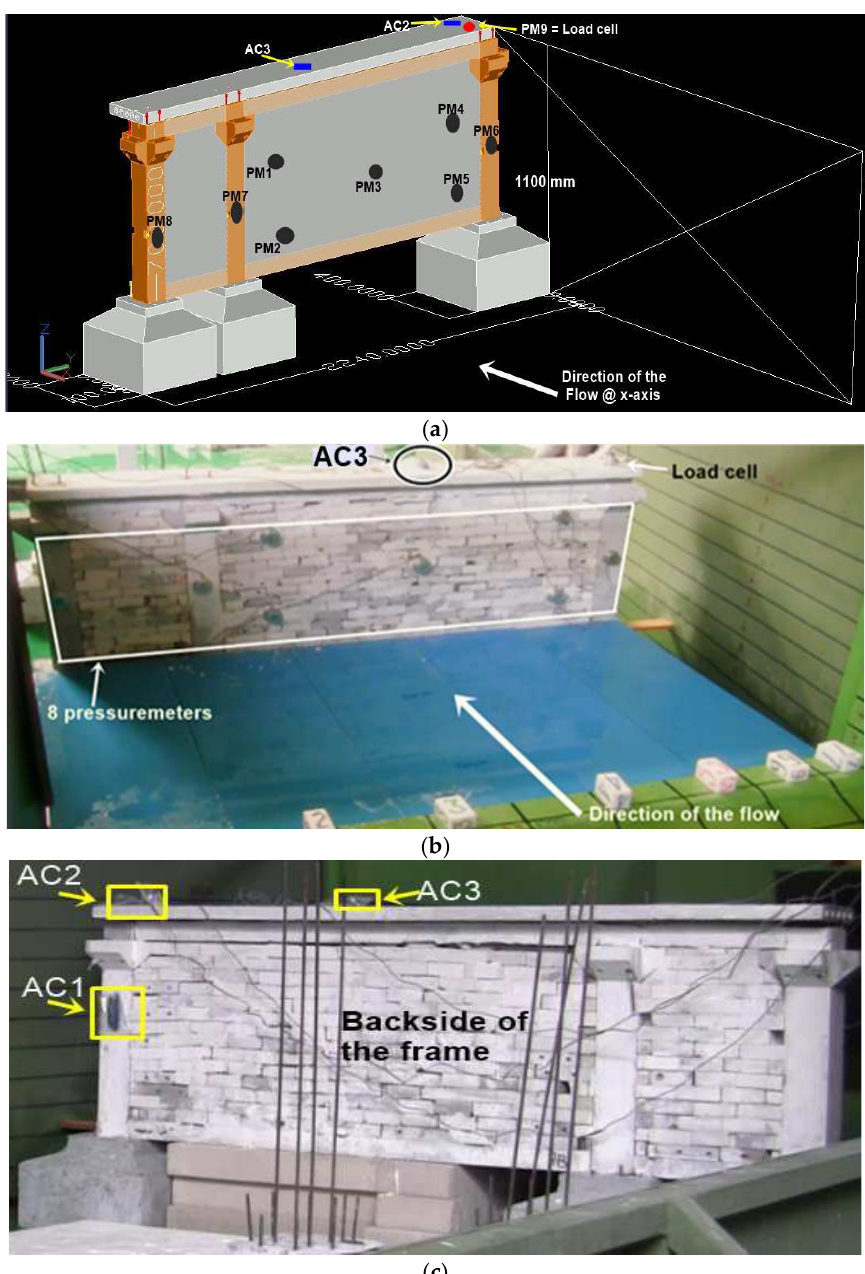
Figure 13. IBS frame ready for testing: ( a ) schematic diagram; ( b ) front of the experimental test; ( c ) back of the frame.